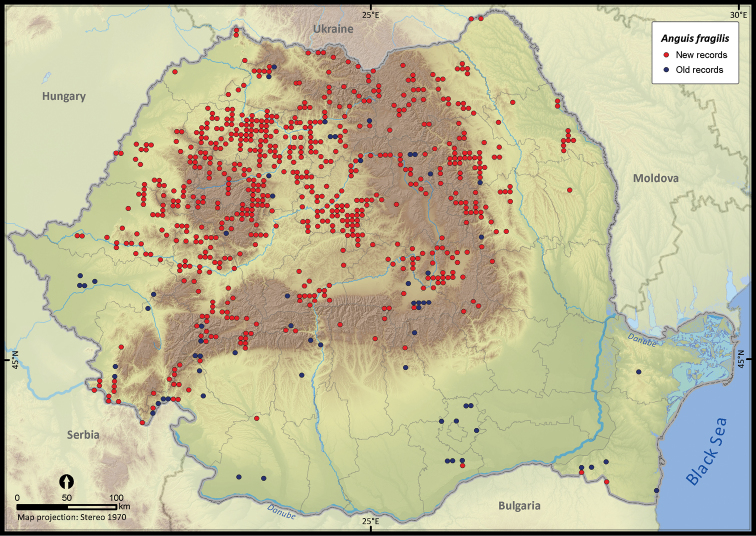
Anguis fragilis.